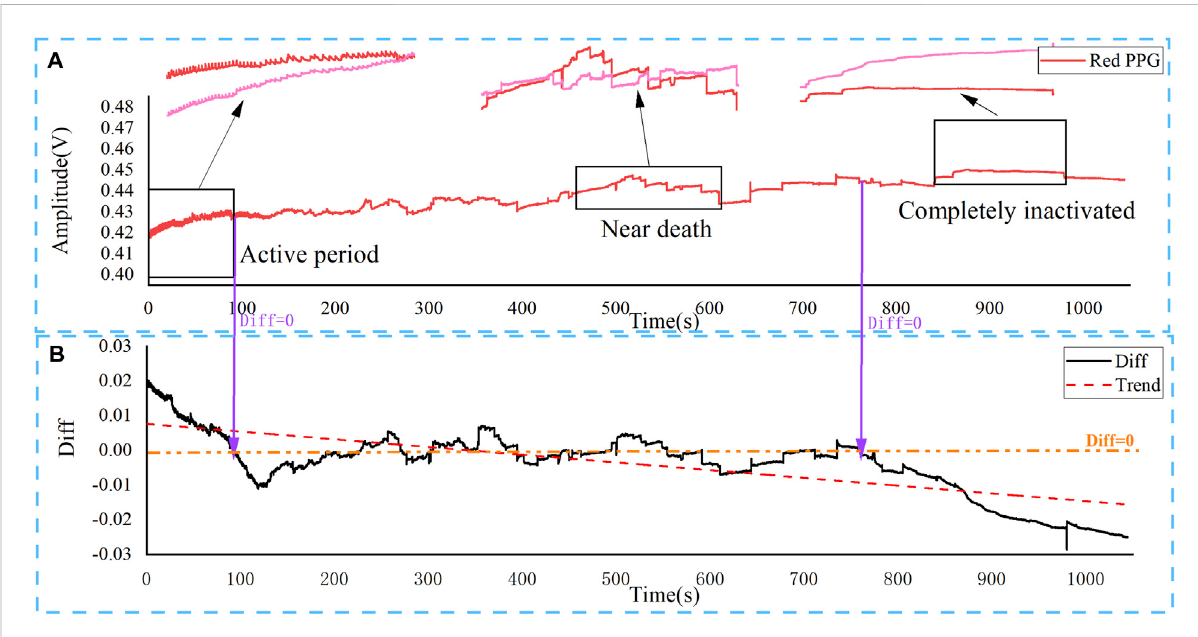
FIGURE 2 Changes of blood supply status in the brain of rats after overdose of anesthetic injection by PPG. The results show three typical periods, corresponding to different blood supply status. (A) Real-time change of red light (660 nm) and infrared light PPG (940 nm); (B) The difference (Diff) between red light and infrared light